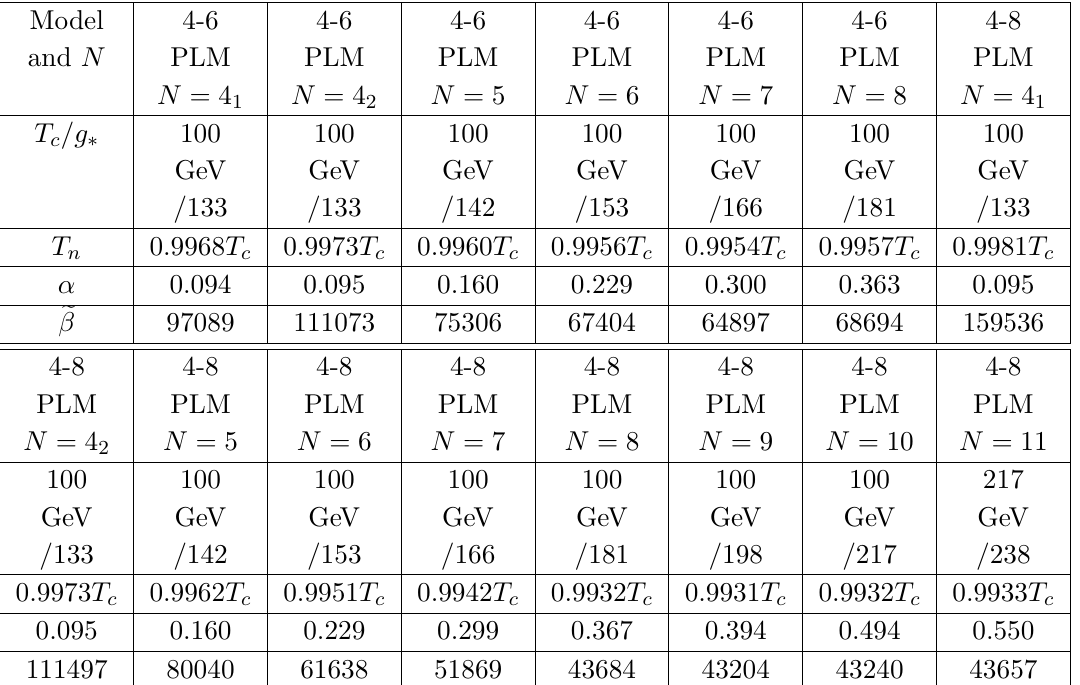
Table 2 . The reference values for the parameters relevant to the GW spectra, predicted from the 4-6 and 4-8 PLMs with N = 4 − 8 , and N = 4 − 11 , respectively. The subscript attached on 4 of N = 4 denotes the same category as introduced in table 1. The SM contribution parameter ζ has been set to